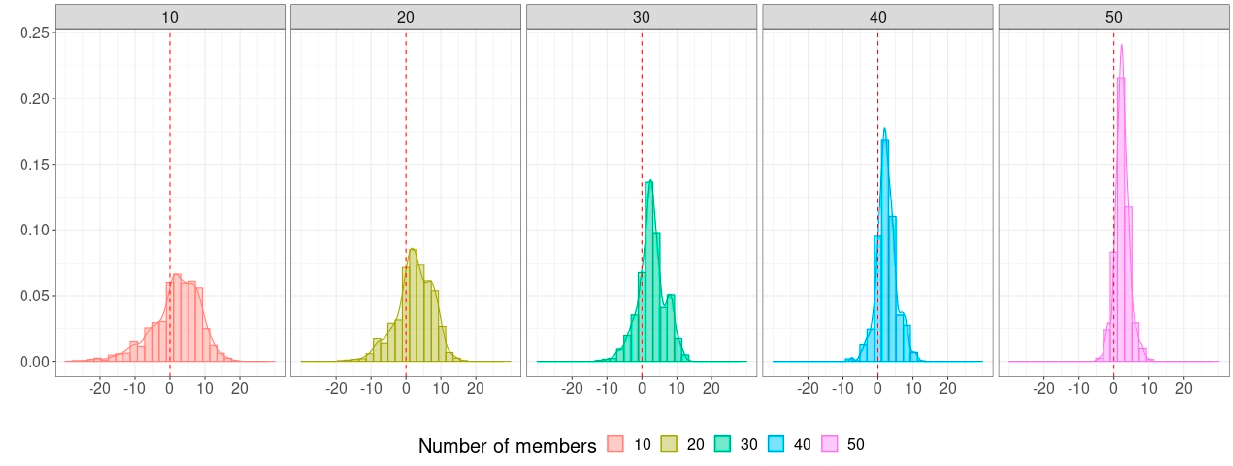
Figure 3. Distribution of the profitability of the cooperative by number of members.